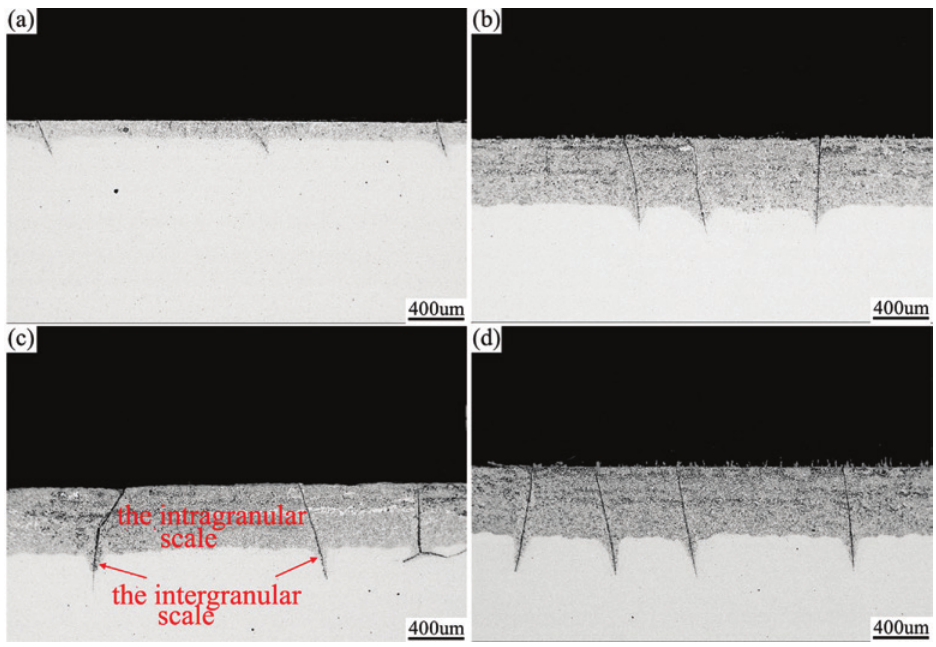
Fig. 3: Cross section morphology of the subscales: (a) 0%O 2 , (b) 3%O 2 , (c) 5%O 2 , (d) 6%O